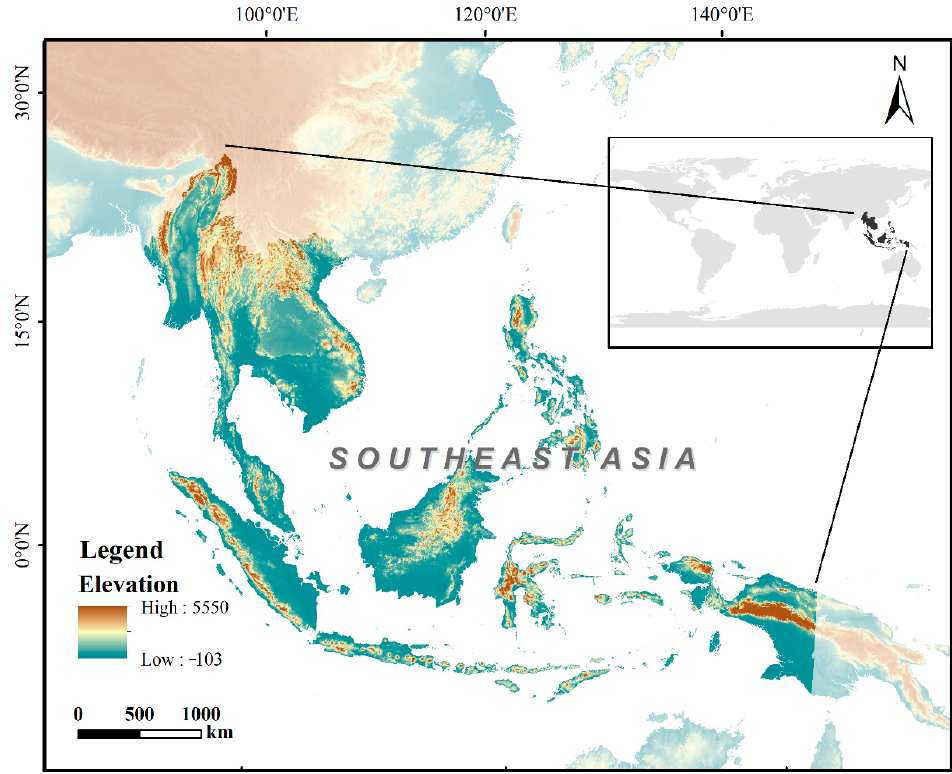
Figure 1. Location and topography of Southeast